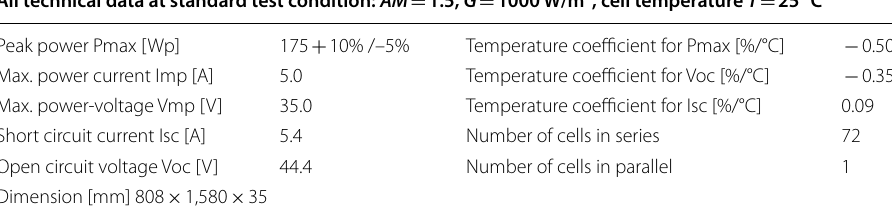
Table 4 Datasheet values of LC175‑24 M PV module http:// www. tehno sat. ro/ PVmod ules/ loren tz_ LC175‑ 24M All technical data at standard test condition: AM